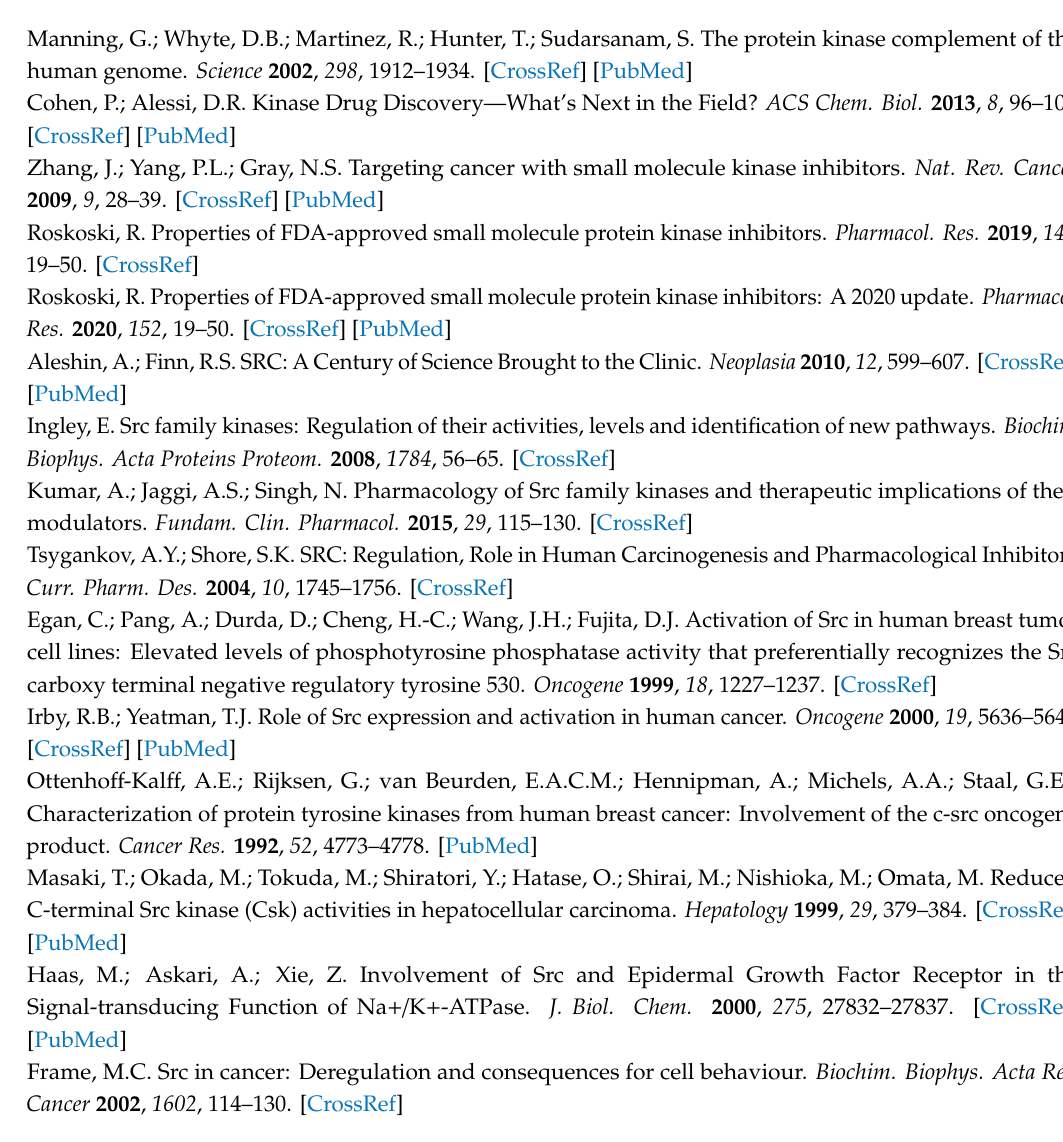
Figure S1: X-ray structure of mutant c-Src in complex with compound 9, Figure S2: Chemical structure of compound 11a, Figure S3: X-ray structure of c-Src in complex with compounds 17 and 18, Figure S4: X-ray structures of c-Src kinase in complex with compound 26, Figure S5: Chemical structures of compounds 31a and 32, Table S1: Summary of the di ff erent types of c-Src inhibitors discussed, Table S2: Index of type-I inhibitors co-crystallized with c-Src kinase discussed, Table S3: Index of type-II inhibitors co-crystallized with c-Src kinase discussed, Table S4: Index of type-III inhibitors co-crystallized with c-Src kinase discussed. Funding: This research received no external